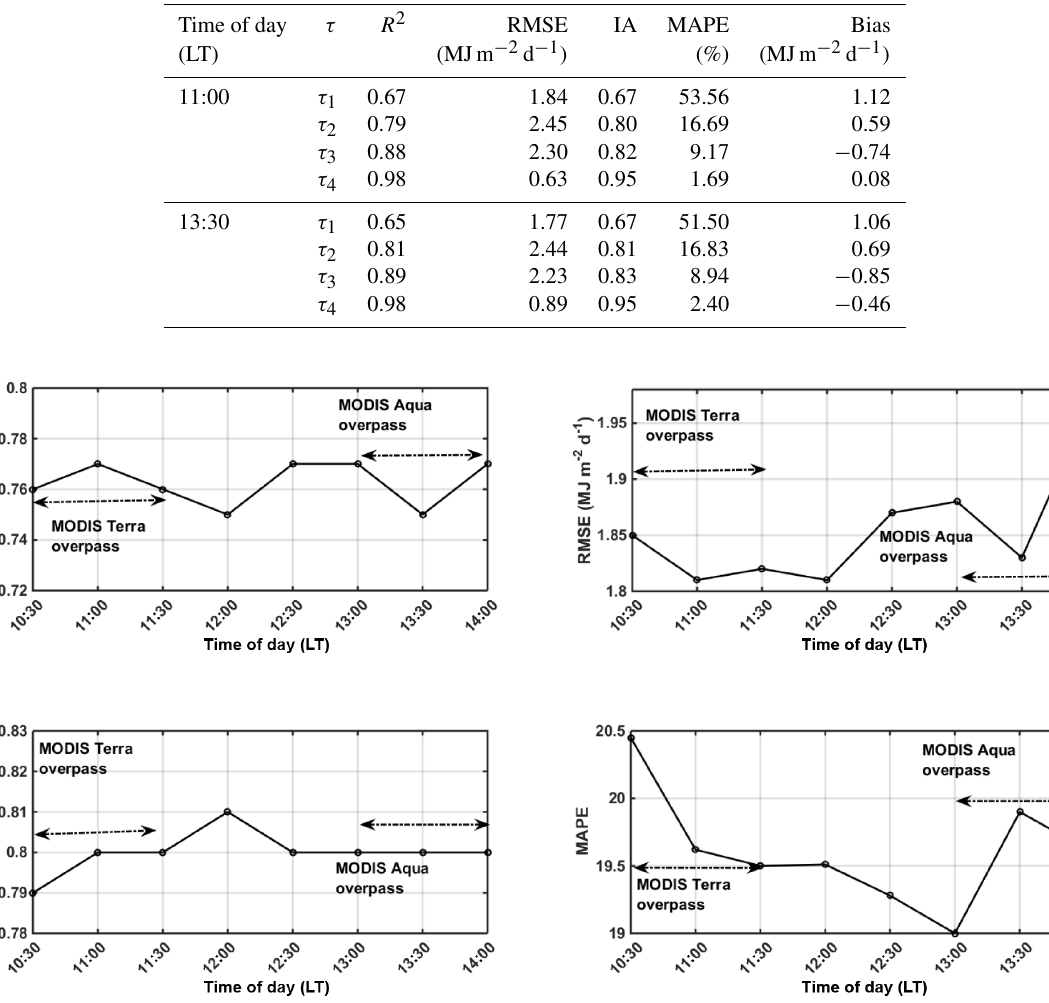
Figure 4. Statistical metric of R Sd_pred by ANN for different times of day. As the study is intended for remote sensing application, we demonstrate the potential of the method for future research in the case where the satellite will be used, and as such we pick MODIS overpass time as an example to highlight the predictive ability of the ANN at the specific overpass